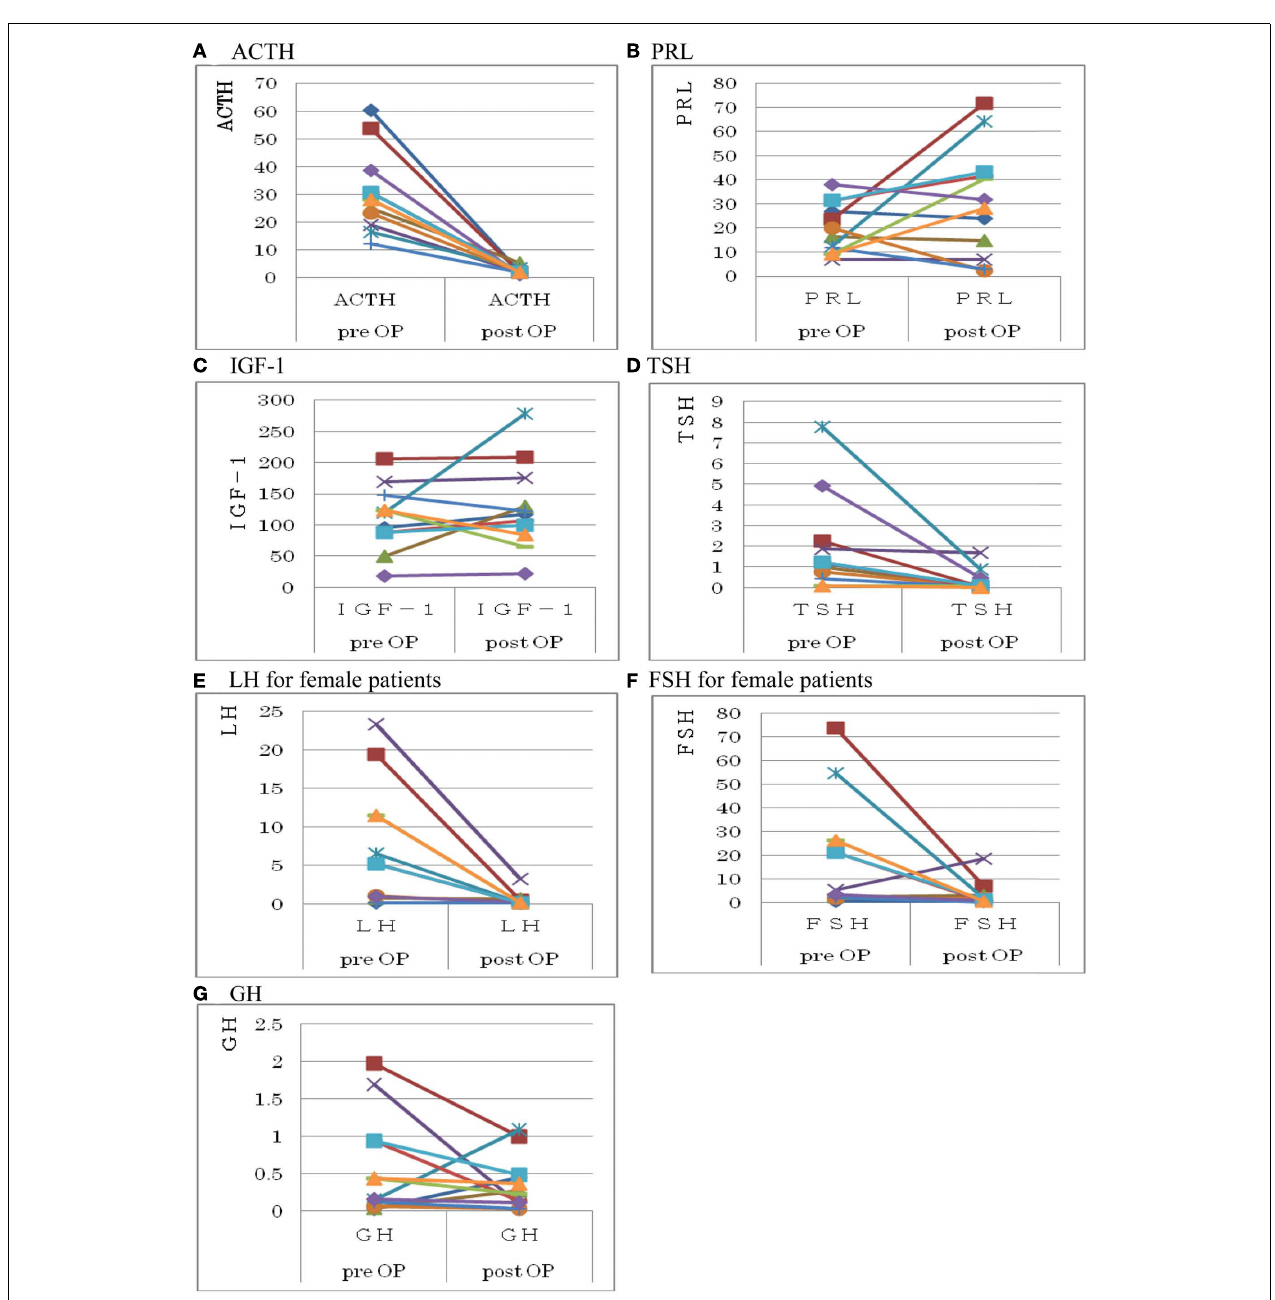
FIGURE 4 | Changes in basal levels of pituitary hormones before and after stalk